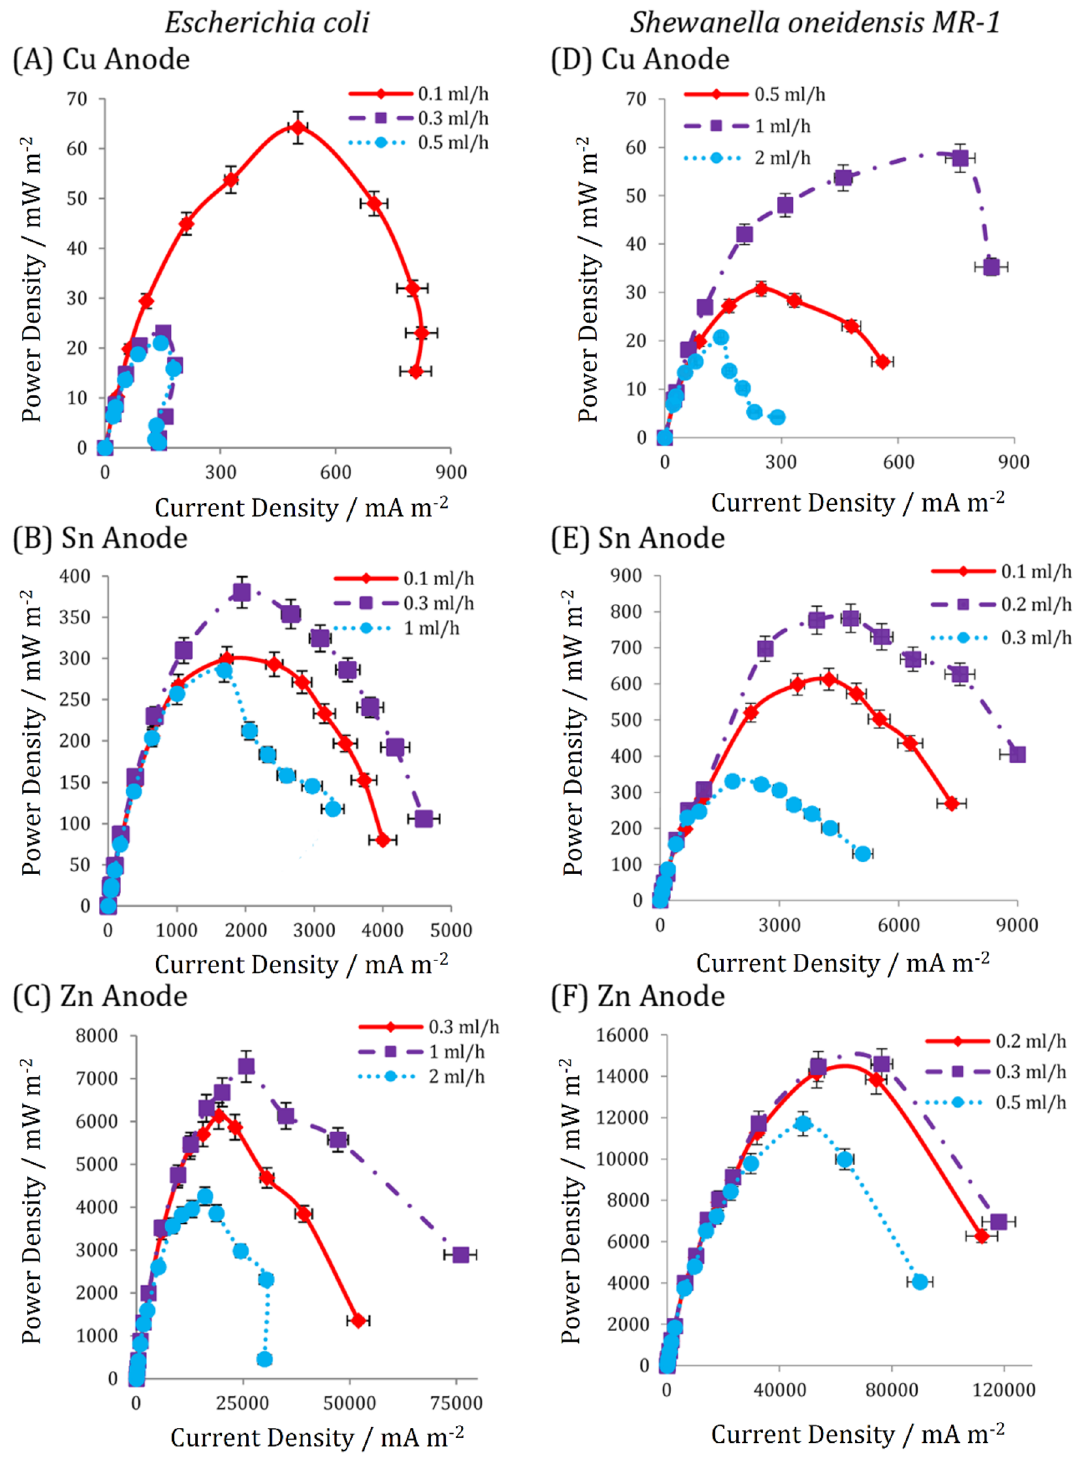
Figure 3. The power density curves for the microfluidic MFCs with different anode electrodes engaged with Escherichia coli (( A ) Cu, ( B ) Sn and ( C ) Zn) and Shewanella oneidensis MR-1 (( D ) Cu, ( E ) Sn and ( F ) Zn) under different substrate injection rates. The error bars represent the variation of power and current densities among repeated